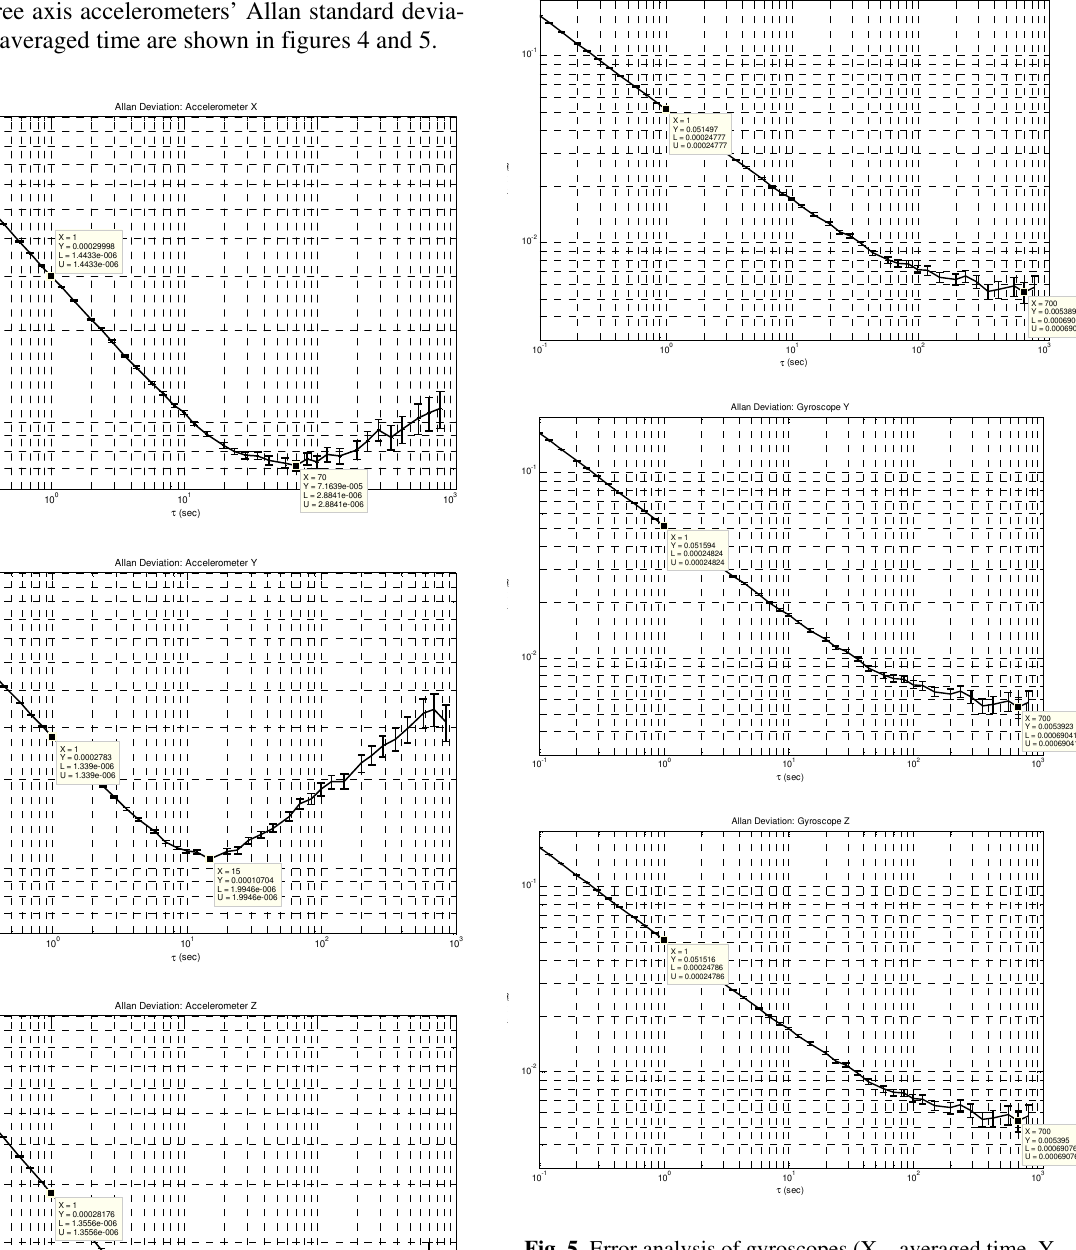
Fig. 5. Error analysis of gyroscopes (X – averaged time, Y – Allan deviation, L – lower sigma boundary, U – upper sigma